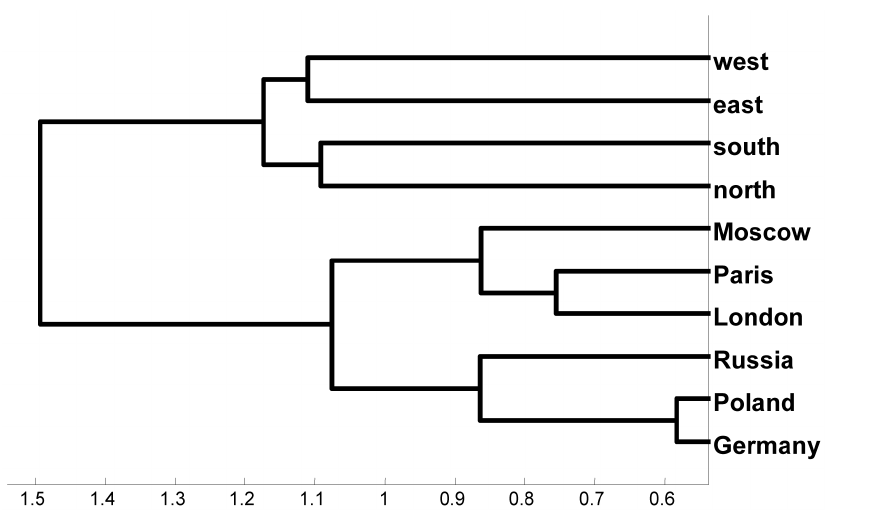
Figure 3. Hierarchical cluster tree computed from the WordNet-based semantic similarity matrix for { London,Moscow,Paris,north, south,east,west,Germany,Poland,Russia } given in Figure 2.